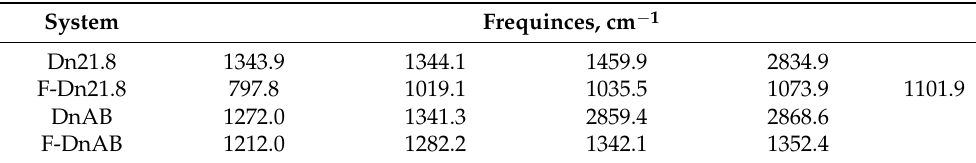
Table 4. Main Raman modes of hydrogenated and fluorinated AB and Dn21.8